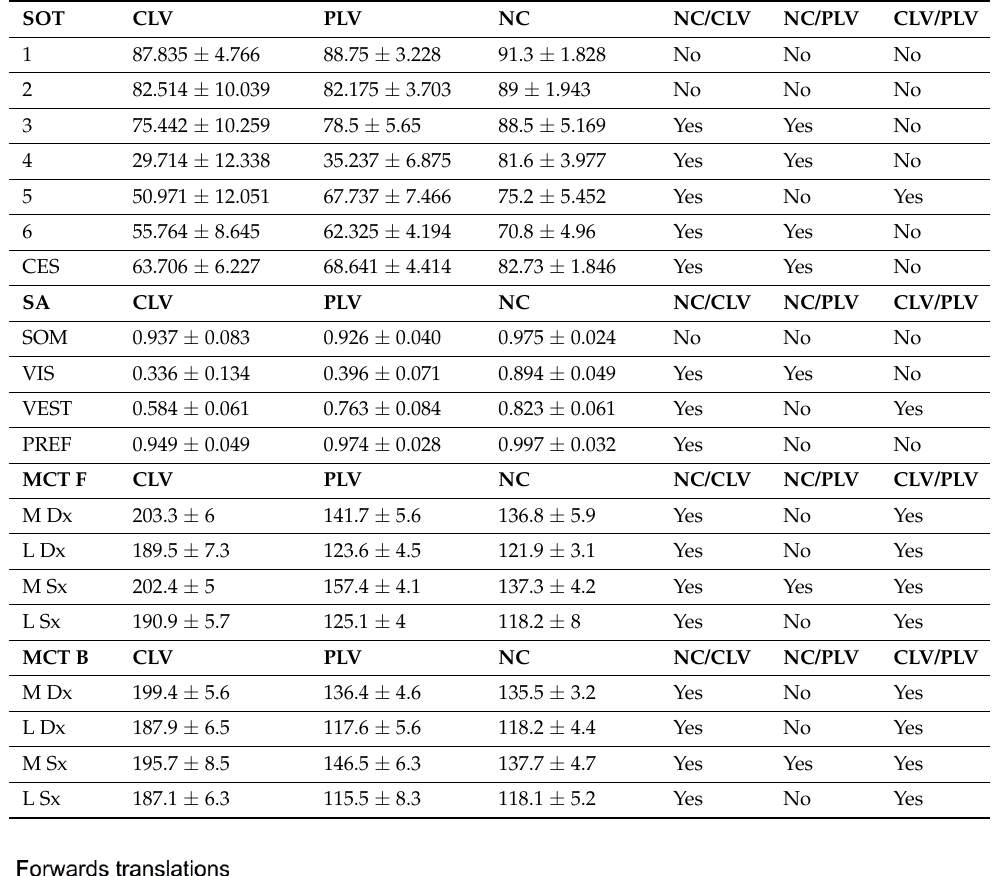
Table 3. Data obtained from Sensory Organization Tests (SOT), Sensory Analyses (SA) and Motor Control Tests (MCT). CLV: central low vision; PLV: peripheral low vision; NC: normal control; SOT (1–6): trial condition; SOM: somatosensory contribution, VIS: visual contribution; VEST: vestibular contribution; PREF: visual preference MCT F: motor control test of medium (M) or large (L) translation